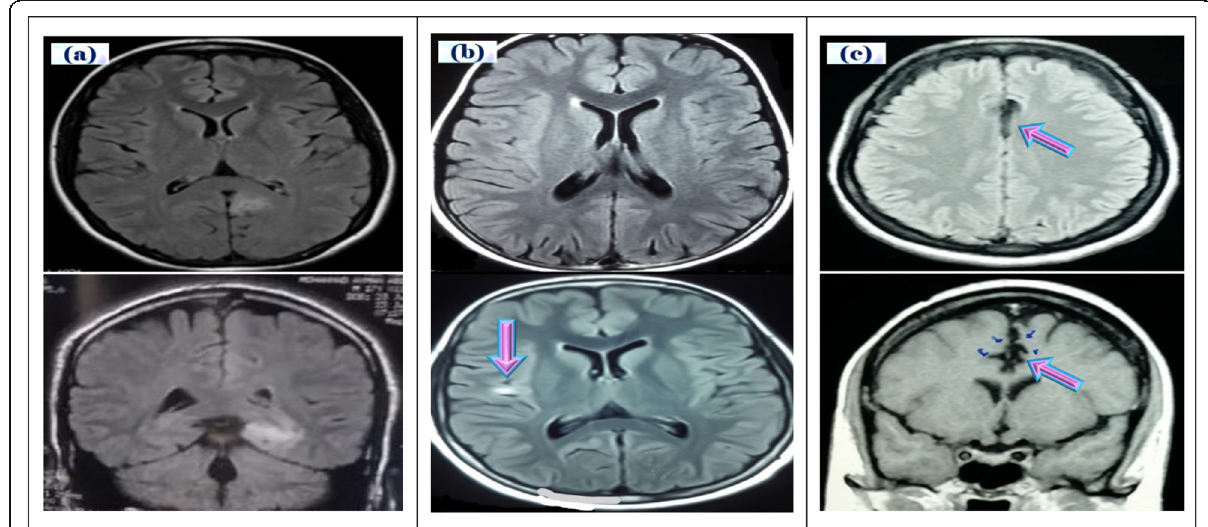
Fig. 2 Magnetic resonance imaging of 3 included cases. a Left limbic lobe focal cortical dysplasia. b Right insular lobe focal cortical dysplasia.